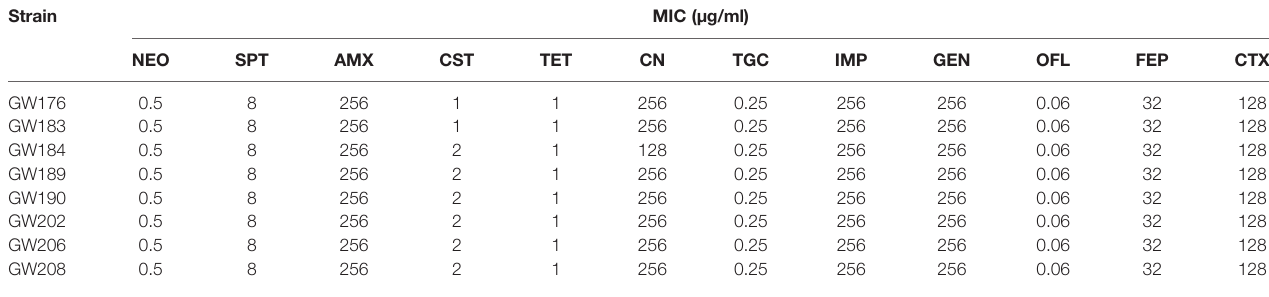
TABLE 3 | Resistance phenotypes of eight bla NDM -positive Escherichia coli isolates. Strain MIC (µg/ml)